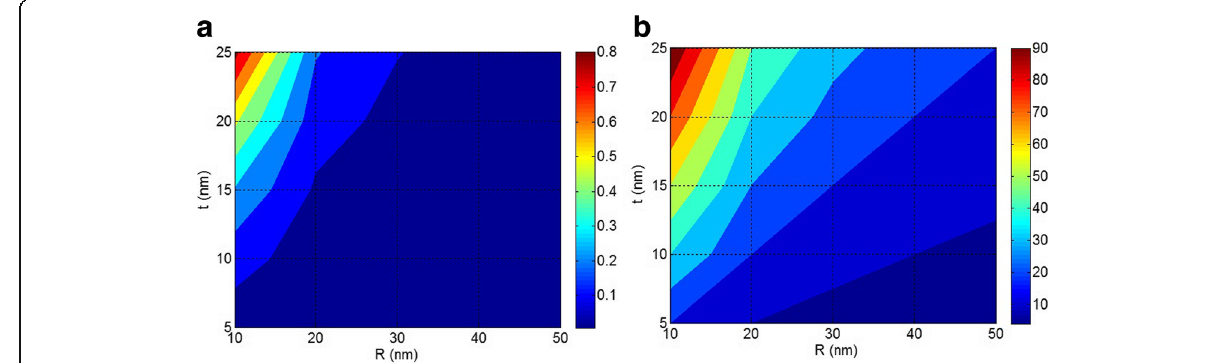
Fig. 5 The correlation of a ϕ i and b a interphase parameter to R and t parameters at ϕ f = 0.02, E f = 100 GPa, and E i = 50